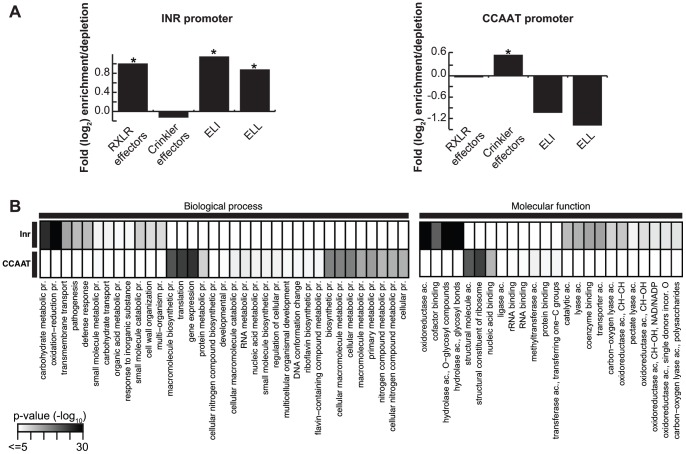
Enrichment/depletion of functional classes in the set of genes with Inr/FPR- or CCAAT-box elements.(A) Log2-fold enrichment/depletion displayed for four classes of genes (RXLR, Crinkler, ELI and ELL) predicted to contain the Inr/FPR- or the CCAAT-box in their promoter sequence. (B) Overrepresentation of GO functional annotation of genes that contain the Inr/FPR- or the CCAAT-box elements in their promoter sequence. Heat map shows the -log10(p-value) of the significant enrichments detected by BiNGO [48]. Non-redundant GO terms (see Material & Methods) with a −log10(p-value) >5 are displayed (see Table S3A for the full list).